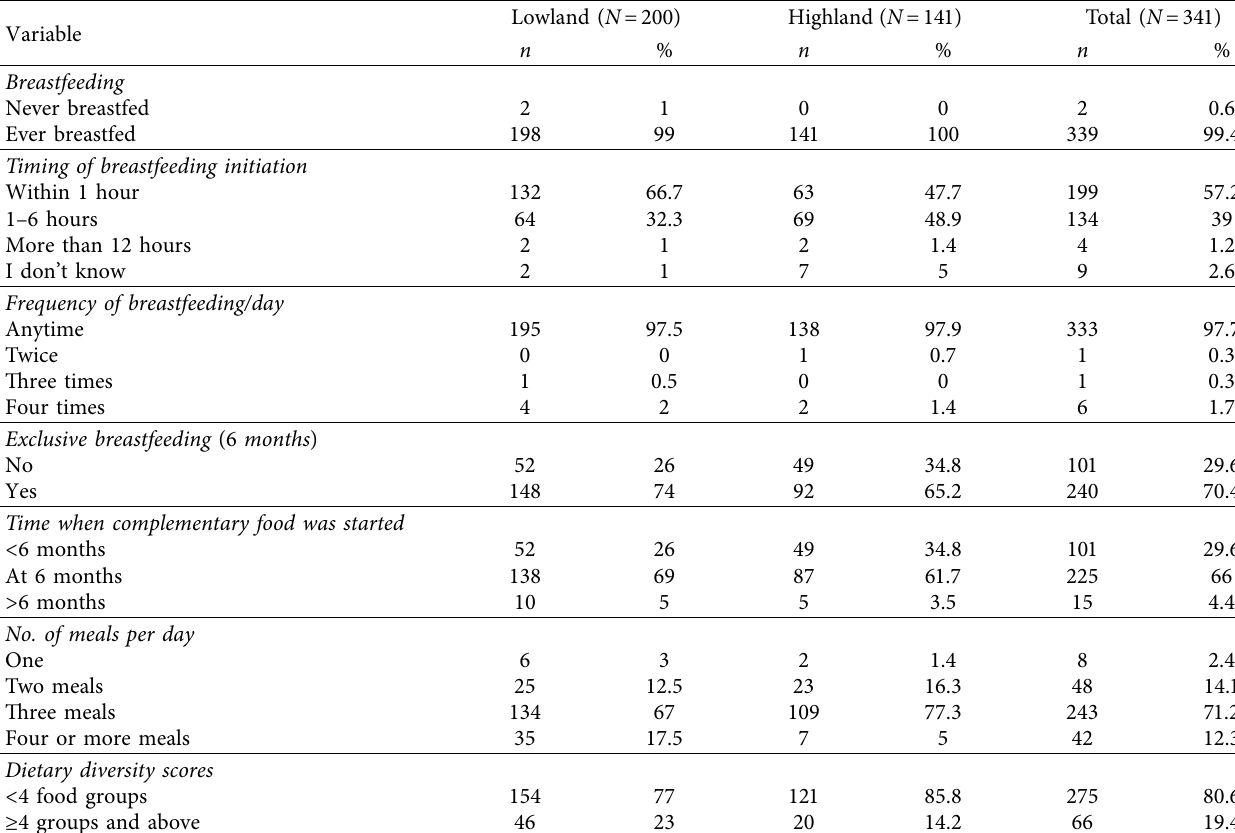
Table 2: Young children feeding practices in the lowland and highland areas ( n � 341).